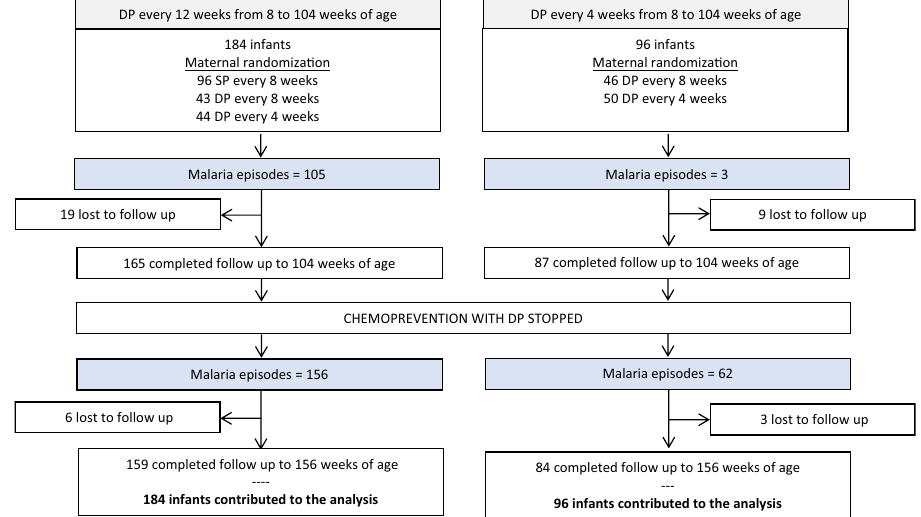
Fig. 2 Study participant follow-up and malaria outcomes in the clinical trial. DP indicates